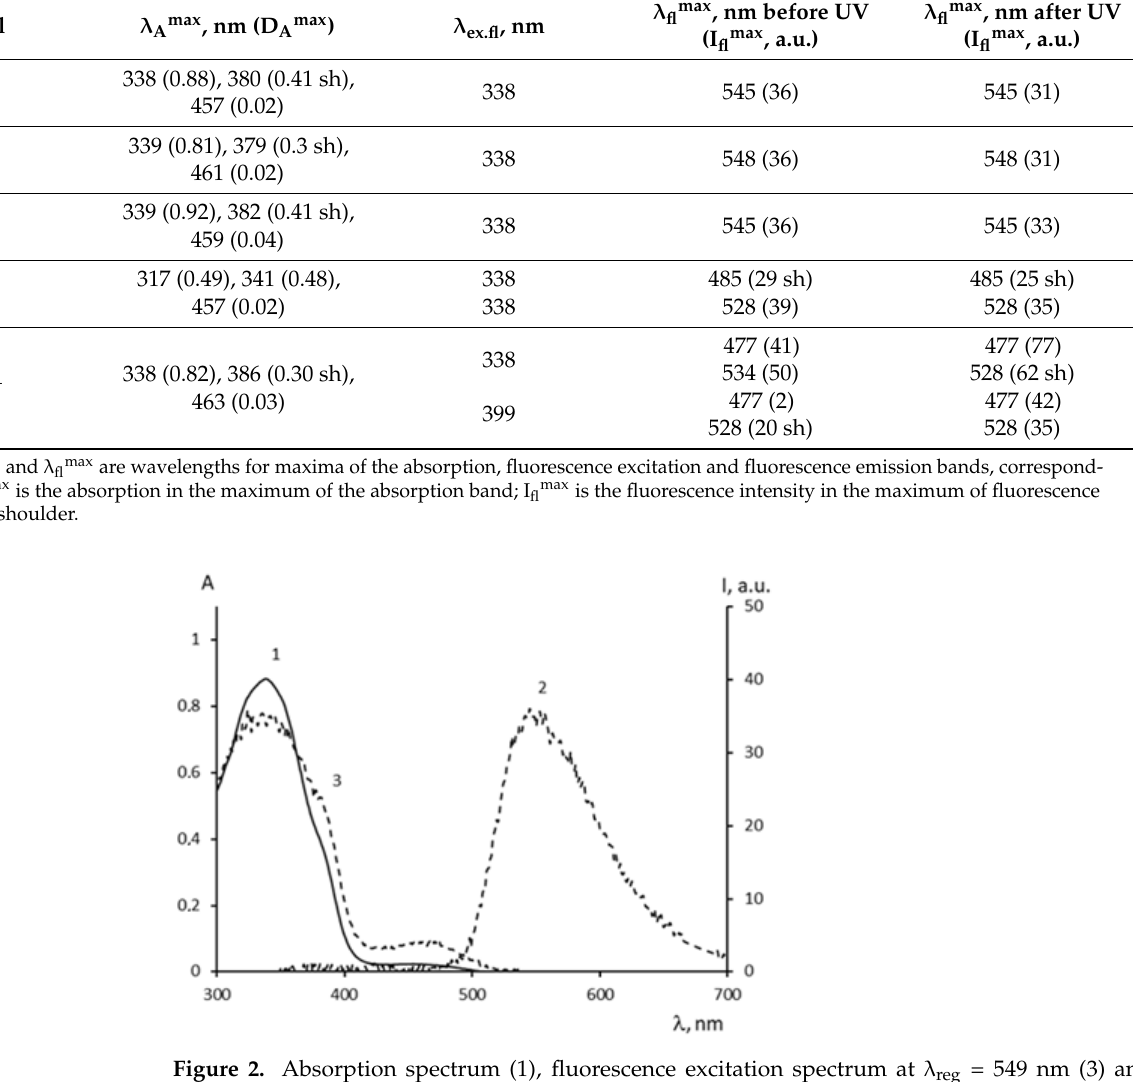
Table 1. Spectral characteristics of the model compound 3 in the toluene/acetonitrile solution with and without metal ions.